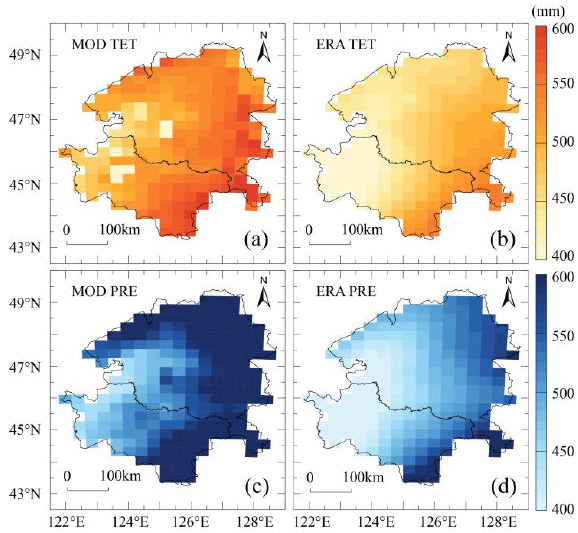
Figure 5. The spatial patterns of total evapotranspiration and precipitation: the WRF-modeled ( a , c ) and ERA Re-analysis ( b , d ). Each grid value is a 5-year average in the growing season (May– September).